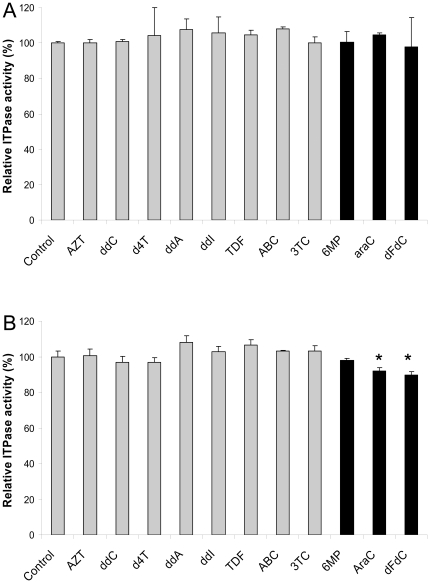
The effect of nucleoside analogues on ITPase activity.A: The effect of the addition of nucleoside analogues (10 µM) on the activity of hrITPase (2 µg). B: ITPase activity of MOLT-3 cells after 18 hr of incubation with 10 µM of the nucleoside analogues indicated; ziduvodine (AZT), zalcitabine (ddC), stavudine (d4T), dideoxyadenosine (ddA), didanosine (ddI), tenofovir (TDF), abacavir (ABC), lamivudine (3TC), 6-mercaptopurine (6MP), cytarabine (araC), gemcitabine (dFdC)* p<0.05.